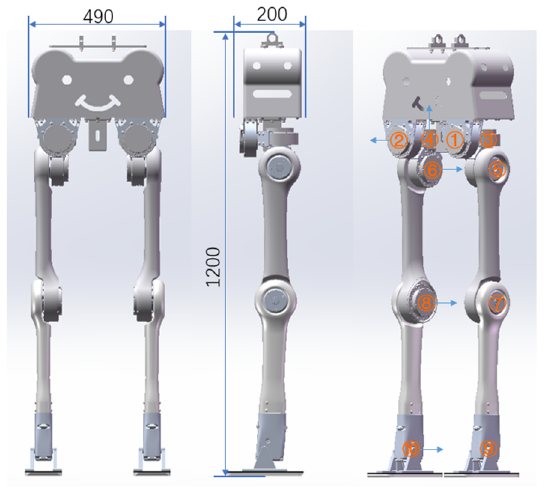
Figure 4. The biped robot model used in this paper. The size of the robot is 490 mm × 200 mm × 1200 mm. The active joints of Roll joint, yaw joint, Pitch joint, knee joint and ankle joint of two legs are numbered from 1 to